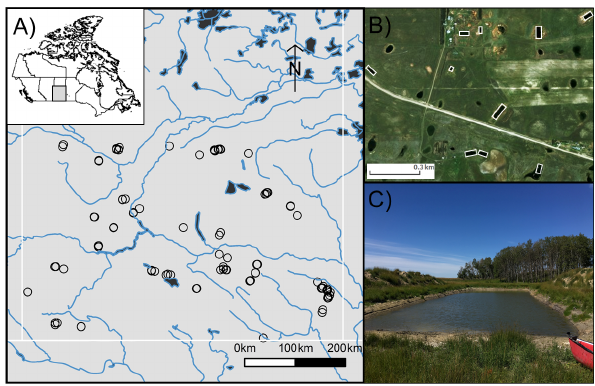
Figure 1. (a) Map of southern Saskatchewan in Canada showing the distribution of studied farm reservoirs, (b) aerial image showing 10 farm reservoirs delineated by white rectangles within a 1km 2 area, and (c) general size and shape of farm reservoirs with two characteristic side mounds of excavated